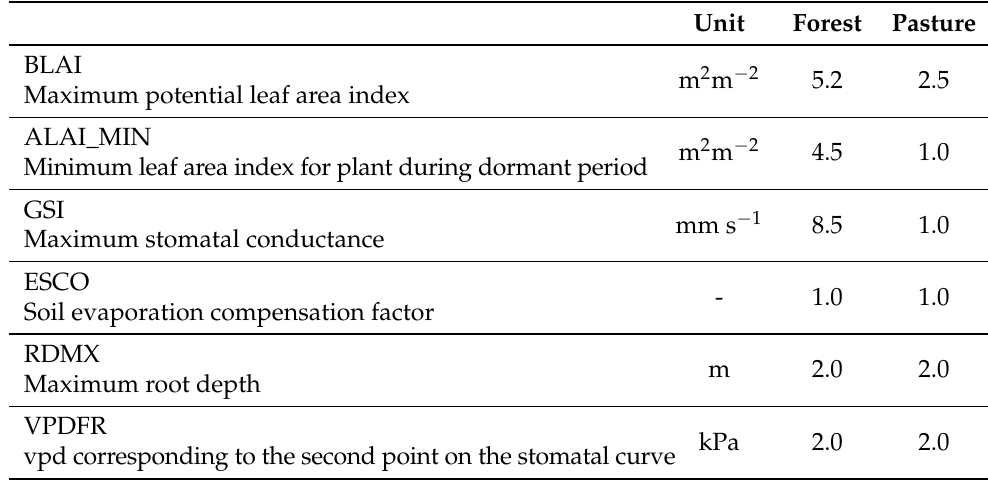
Table A1. Parameters used in the evapotranspiration adjustment process, for forest and pasture land covers.